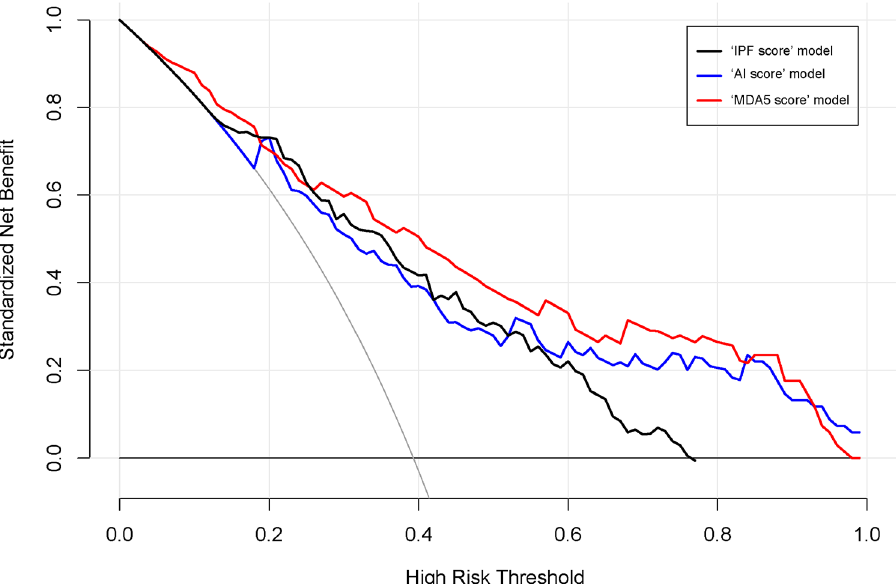
Figure 4. Decision curve analysis for ‘IPF score’, ‘MDA5 score’ and ‘AI score’ model. The concept of population net benefit (NB) is fundamental to decision curves (measured in the y-axis) and referred to